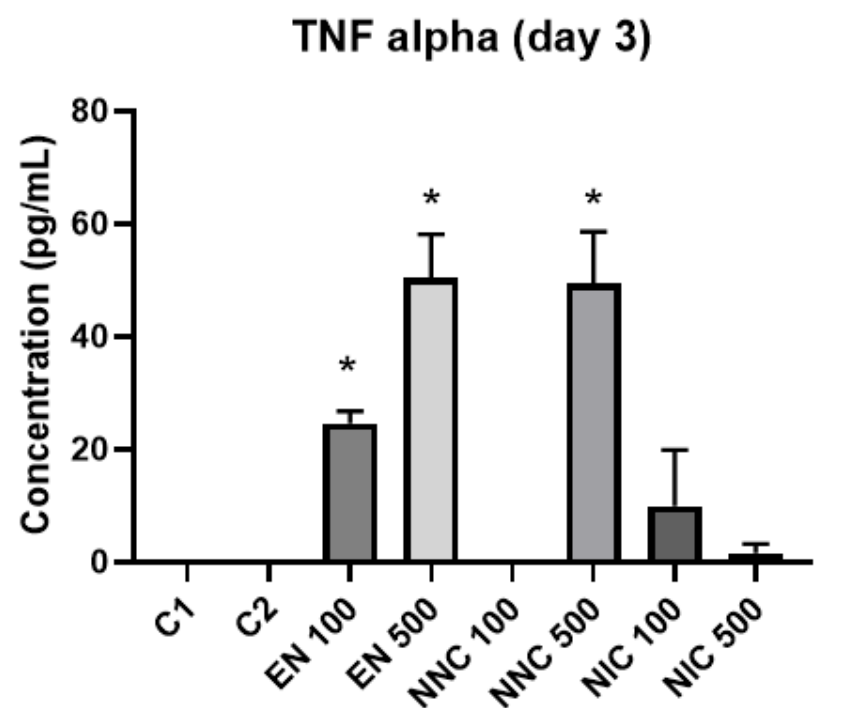
Figure 13. TNF- α detection three days after treatment with nanocapsules. C1 = control cells with no nanocapsule treatment and no LPS stimulus; C2 = control cells stimulated with LPS but no nanocapsule treatment (* p < 0.05, EN100, EN500, NNC500 vs. control).